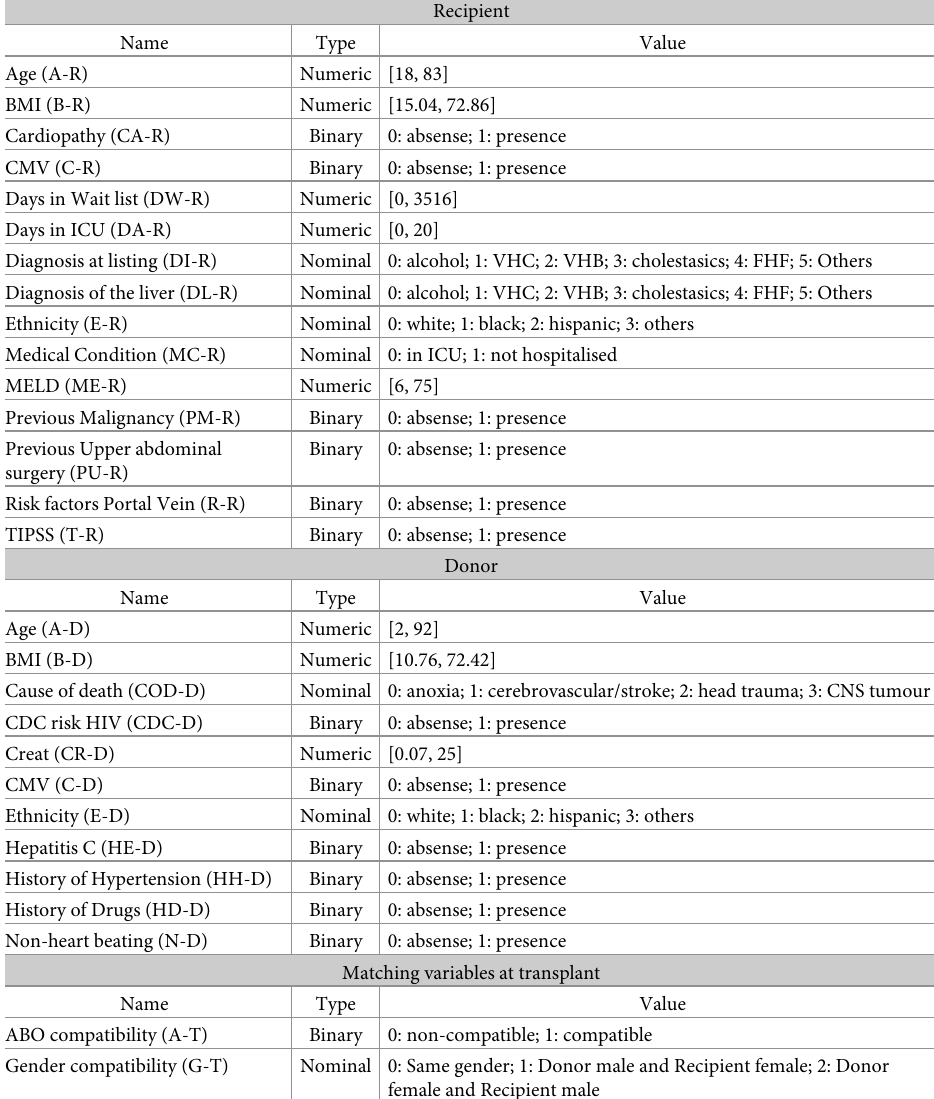
Table 2. Main characteristics of the features considered: Name, type and